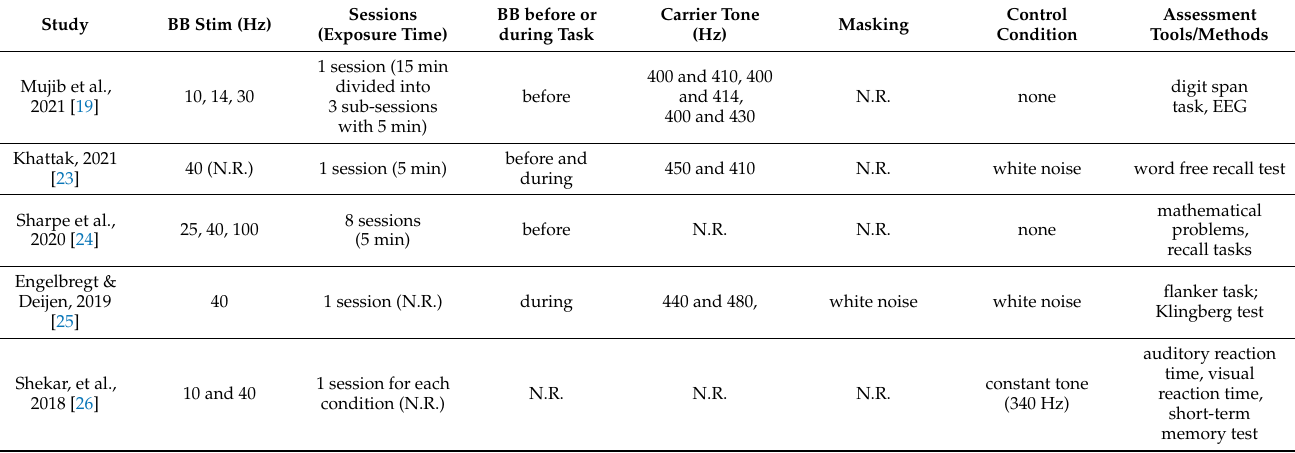
Table 1. Characteristics and intervention protocols of some studies that approached BB and memory found in the